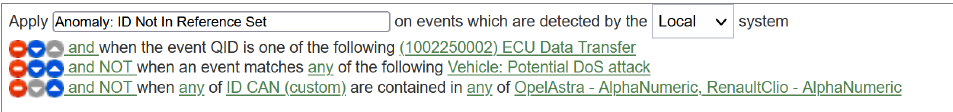
Figure 15. Fuzzing rule in QRadar.